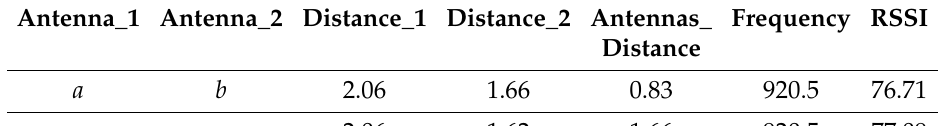
Table 4. Data set with top 5 records of features.